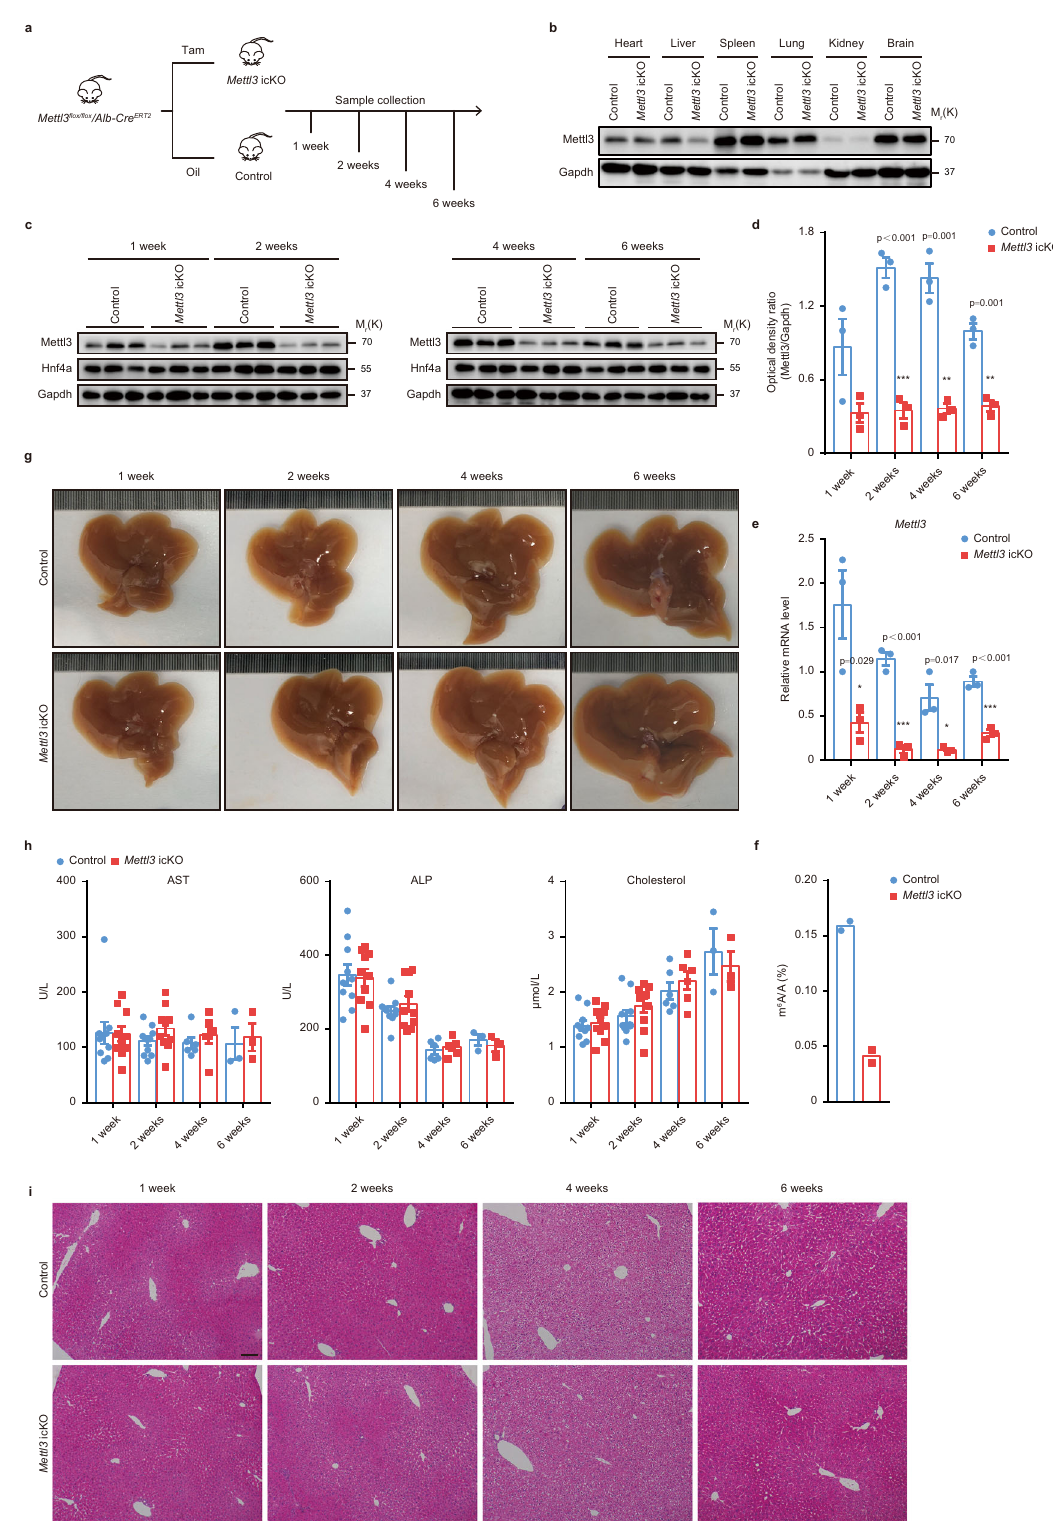
mRNA stability assay mRNA stability assay was performed on primary hepatocytes and HepG2 cell line. Primary hepatocytes were isolated from Control and hepatic Mettl3 cKO mice. Cells were cultured overnight and then treated with 5 μ M actinomycin D (Sigma-Aldrich, A1410) for 0 h, 1 h, 2 h, 4h, and 6h. HepG2 cells were cultured and treated with 5 μ M actinomycin D for 0 h, 40min, 2 h, and 4 h. For RT-qPCR analysis, total